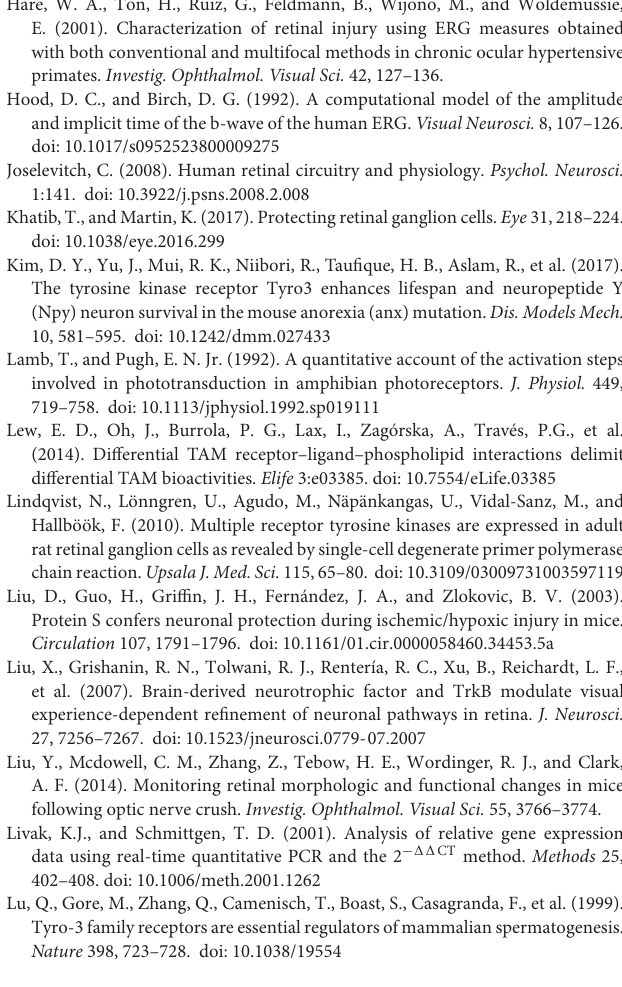
(Nguyen et al., 2013). The reduction in function of cell classes in Tyro3 mice is shown relative (% ± SEM) to the WT group. Gray boxes represent the 95% confidence interval (CI) of the gain relationship between photoreceptors and downstream cell types. Functional losses are considered independent of upstream functional losses if they fall outside the CI. FIGURE S3 | Tyro3 mRNA is expressed in RGCs. The expression of the Tyro3 gene in purified primary mouse RGCs was quantified using reverse transcription-quantitative polymerase chain reaction (qPCR). (A) The purity of the RGC preparation was assessed using the expression of the key RGC gene (Rbpms) in purified cells derived from WT mice ( n = 5–8, N = 2) compared with whole retina. A greater than four-fold enrichment of Rbpms mRNA in purified cells was observed, although some contamination with RPE cells was also detected. (B) Tyro3 mRNA expression is enriched in purified RGCs compared with the whole retina. FIGURE S4 | Optical coherence tomography. The retinas of WT and Tyro3 KO mice were imaged using optical coherence tomography (OCT) ( n = 10 mice/genotype) (A) ganglion cell-inner plexiform layer (GC-IPL), (B) the inner nuclear layer (INL), (C) the outer plexiform layer (OPL), (D) the outer nuclear layer (ONL), (E) the outer segment of the photoreceptor layer (OUTER), and (F) the retinal pigment epithelium (RPE) were quantified. No significant differences were observed in the thicknesses of the layers described (A–F) . Results are presented as mean ± SEM; p -value of mean differences were calculated using a two tailed Student’s t